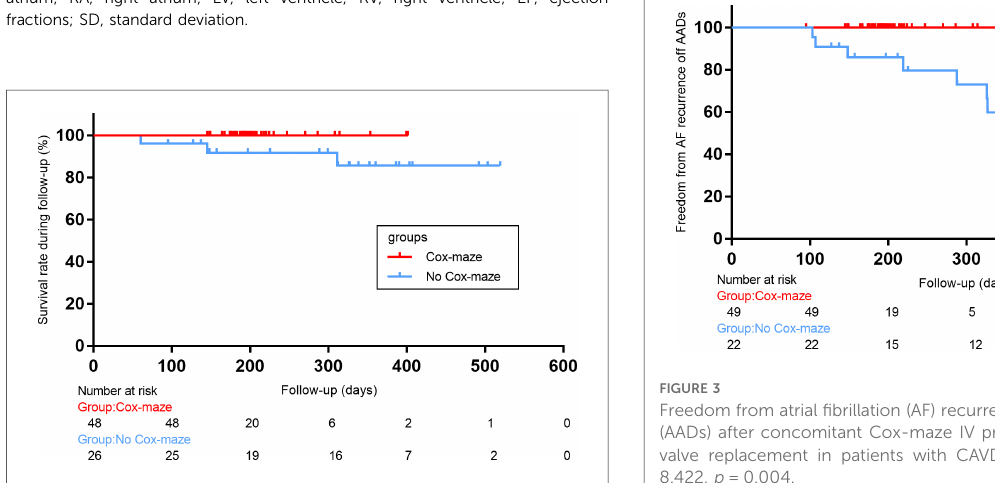
FIGURE 1 Kaplan-Meier overall survival curve after concomitant Cox-maze IV procedure with surgical aortic valve replacement in patients with CAVD and AF. Log-rank statistic 3.915, p =0.046.